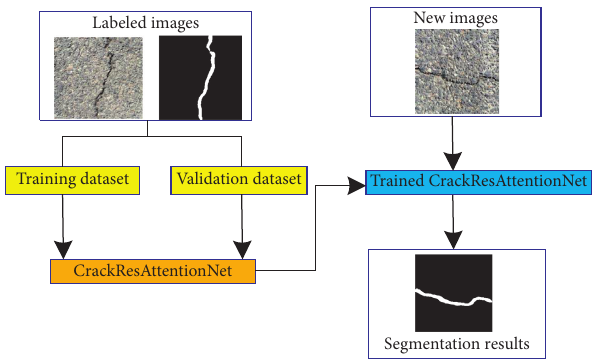
Figure 1: Process for detecting asphalt pavement crack segmen- tation by